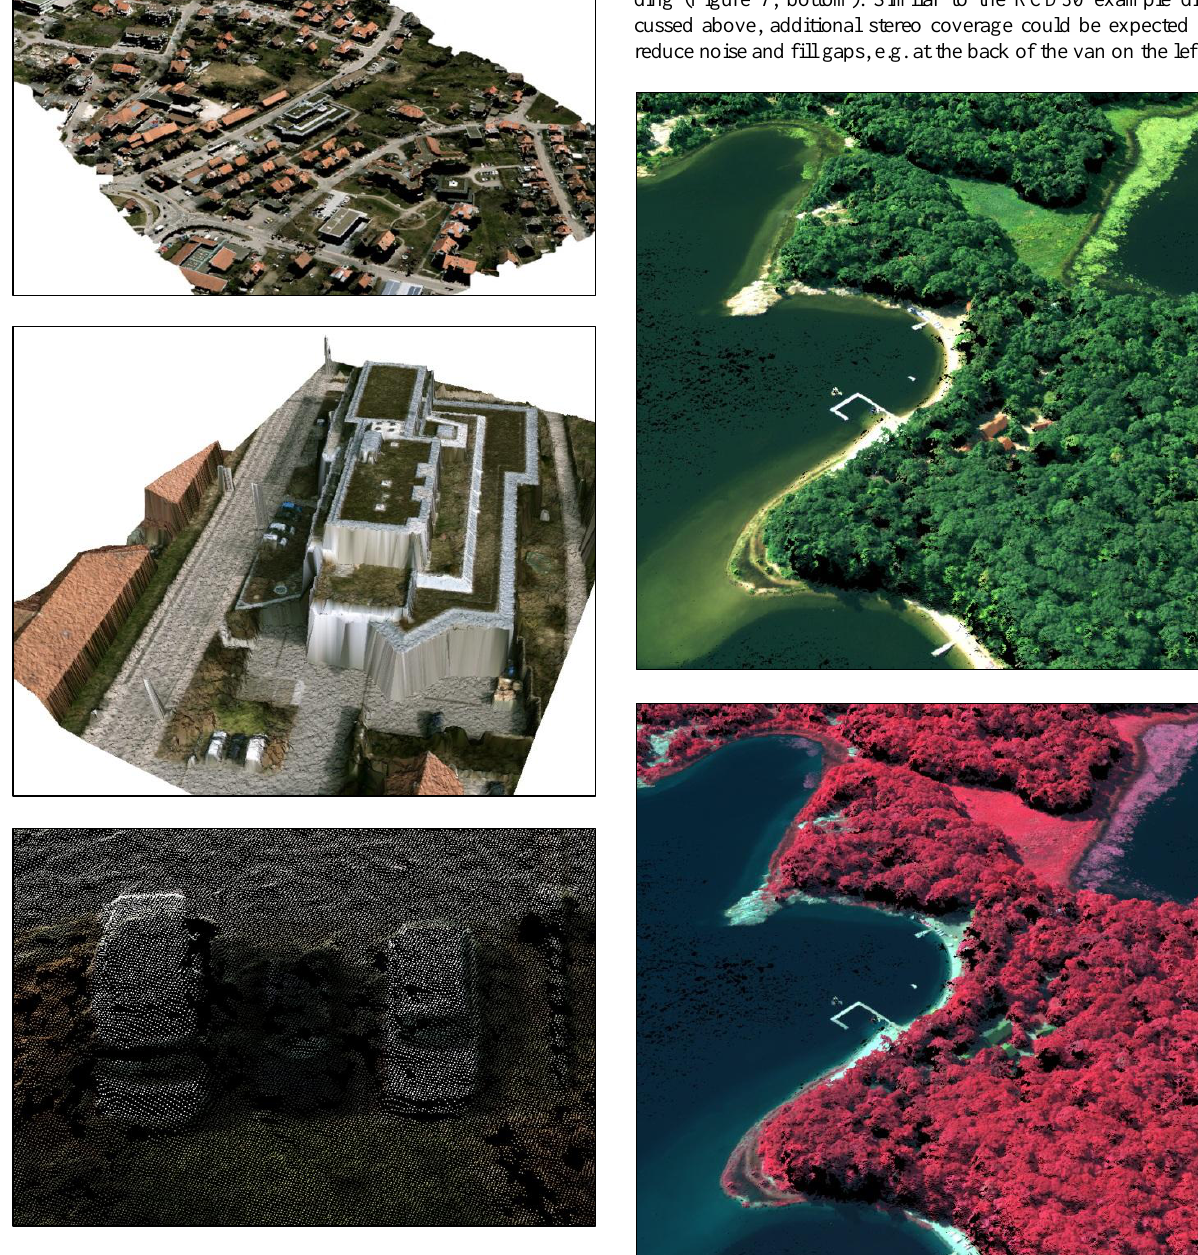
Figure 7: RGB colored info cloud of a DMC-II 140 stereo over- lap in Aalen, Germany (top); TIN view of the Z/I Imaging buil- ding (center); and enlarged info cloud of cars parked in front of that building to illustrate the high point density (bottom).